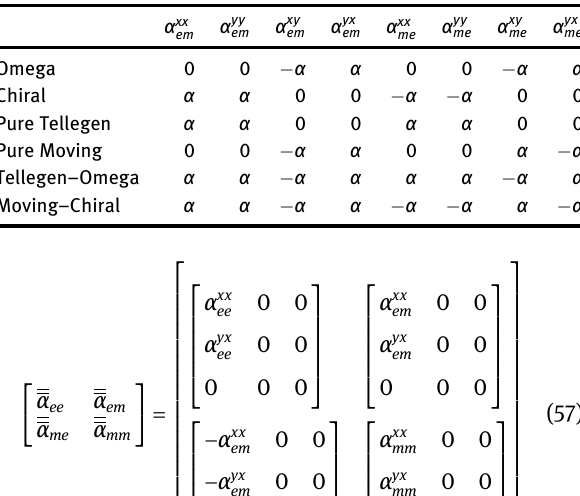
Table  : Summary of transverse magnetoelectric polarizabilities of canonical particles.